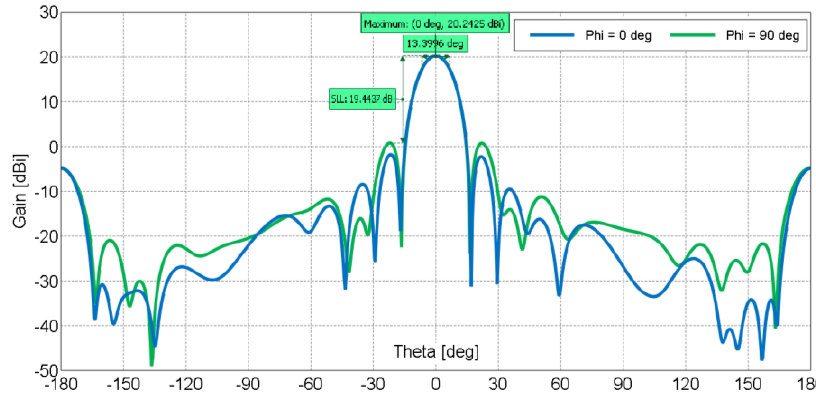
Fig. 7. The antenna array radiation pattern in Cartesian coordinates at central beam position and frequency of 5 GHz.